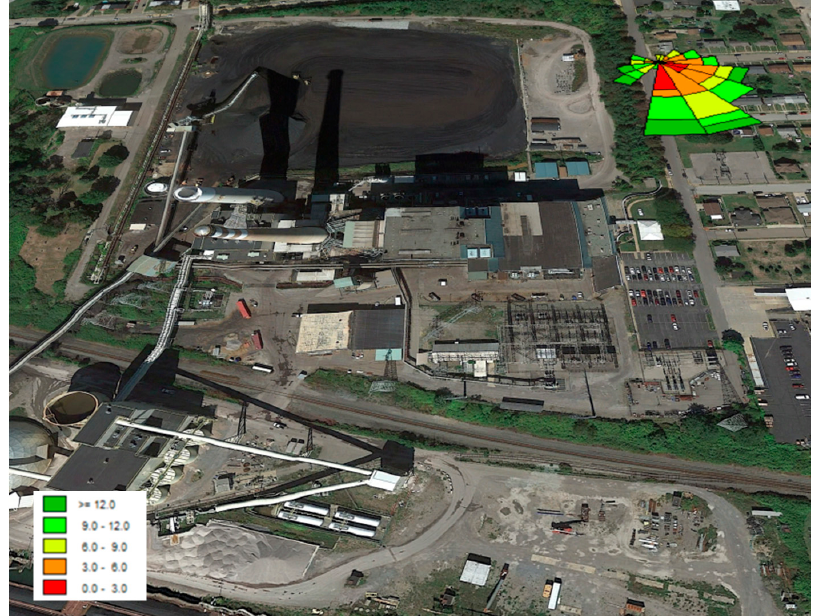
Figure 7. Wind rose created for PM 10 concentrations measured at Station 1. Green colors represent the highest concentrations of particulate matter while the orange and red colors represent lower concentrations of particulate matter, as shown in the legend. Units of particulate matter concentration are μ g m − 3 . The upper side of the wind rose represents North. The length of the wind rose vectors represents average wind speed, where the longer vectors represent a higher average wind speed.